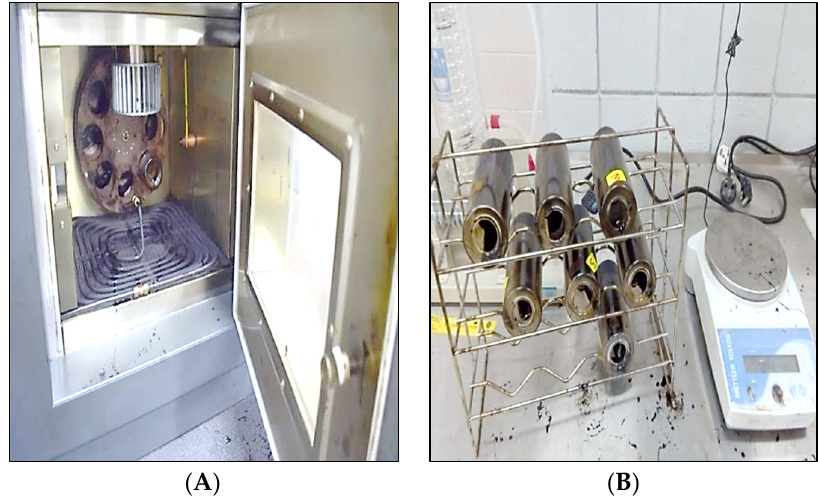
Figure 5. RTFOT apparatus. ( A ) Rotating oven; ( B ) RTFO bottle.